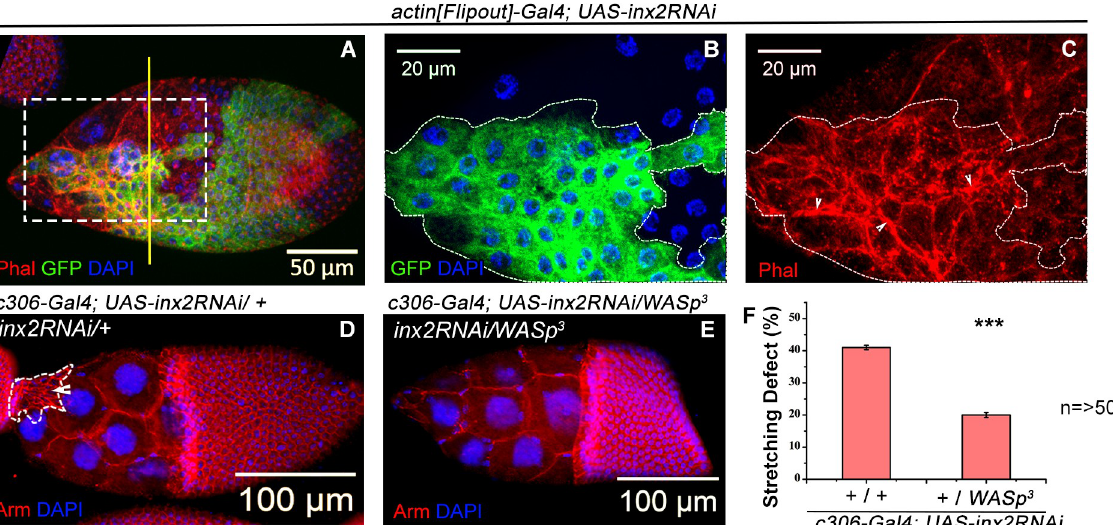
Fig 4. Inx2 modulates Wasp to effect shape change of AFCs. (A) Mosaic analysis-employing actin[Flipout]-Gal4 resulting in overexpression of inx2RNAi in clones. White box marks the region magnified in B and C. (B) White dotted line denotes clones over expressing inx2RNAi is depicted in Green (GFP). (C) Phalloidin imaged in Red indicates the status of F-actin in the inx2RNAi over expressing clone. Note the presence of elevated levels of F-actin in the Inx2-depleted follicle cells. Yellow line demarcates the anterior follicle cells that will stretch from the centripetal and main body follicle cells. (D-E) Stage-10 egg chambers of indicated genotypes. Anti-Armadillo shown in Red and DAPI is in blue. White dotted line outlines the unstretched follicle cells. (F) Quantification of stretching defects seen in the samples from the indicated genotypes. Please note the rescue of the Inx2-depleted stretching defect in WASp 3 /+ background. ��� represents p-value < 0.001. n = number of egg chamber analyzed. Error bars represent Standard Error of Mean.